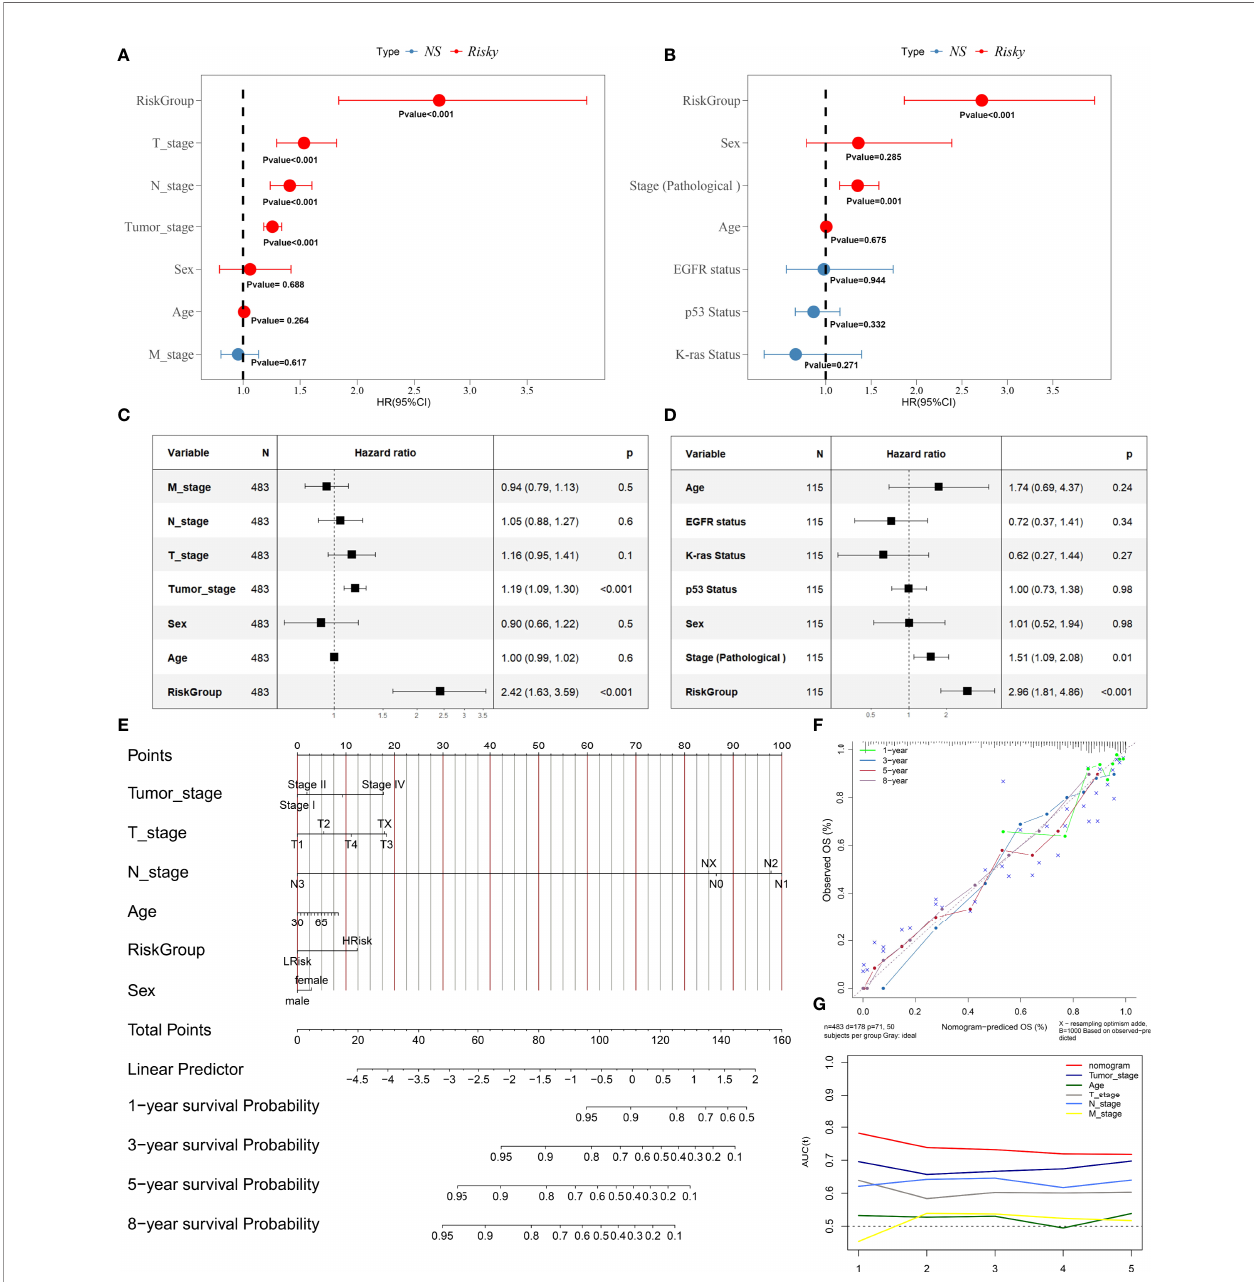
FIGURE 5 | Evaluation of risk score as an independent prognostic factor and construction of nomogram for predicting overall survival in LUAD patients. (A – D) Results of the univariate and multivariate Cox regression analyses regarding OS in the TCGA and GEO. (E) Construction of the nomogram was based on sex, age, risk score, tumor stage, T stage, and N stage in the TCGA cohort. (F) Calibration plot analysis indicated that the nomogram showed a high accuracy of survival prediction. (G) tROC analysis demonstrated that the nomogram had the most powerful capacity for survival prediction by comparing with other clinicopathological